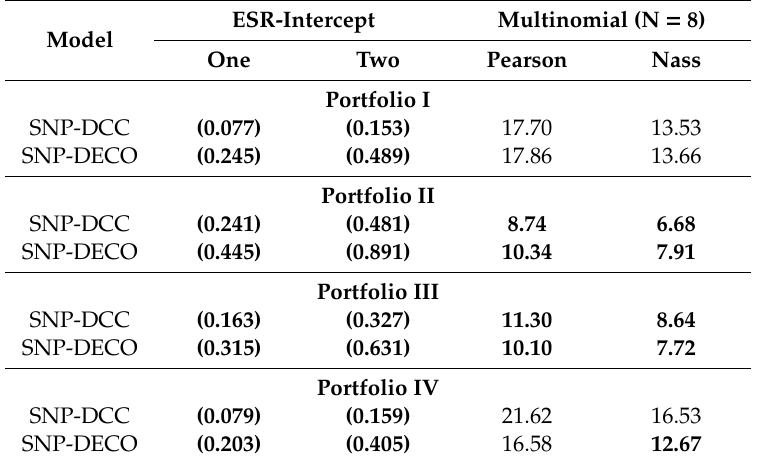
Table 5. Expected Shortfall Backtesting for semi-nonparametric (SNP) DCC and DECO Models. ESR-Intercept Multinomial (N = 8) Model One Two